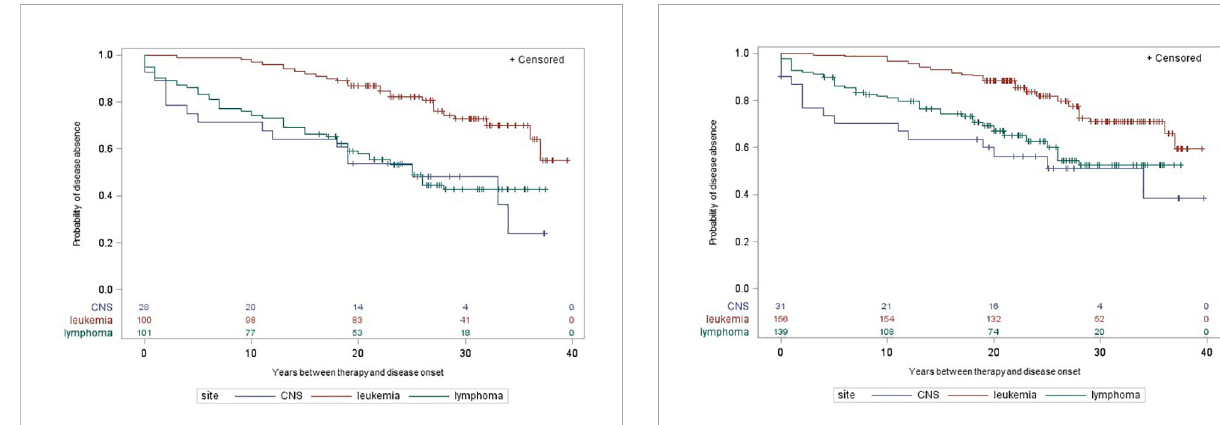
FIGURE 2 Time between self-reported chemotherapy and onset of late adverse diseases of the thyroid gland by cancer site in participants of the nested case-control study KiKme. Participants were included, if they received radiotherapy for a fi rst primary cancer diagnosis (n=392). Thyroid cancers occurring as second primary neoplasms were excluded for this analysis. CNS, central nervous